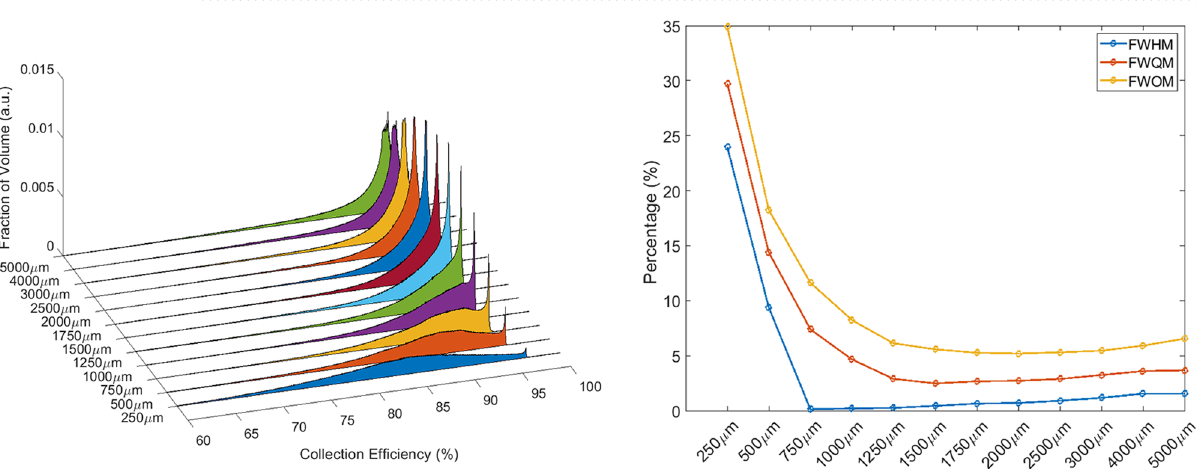
Figure 10. 20 × 20 × 10 mm 3 PAs obtained from detectors with different pixel sizes (left). Dependence of FWHM, FWQM, and FWOM on pixel size (right).